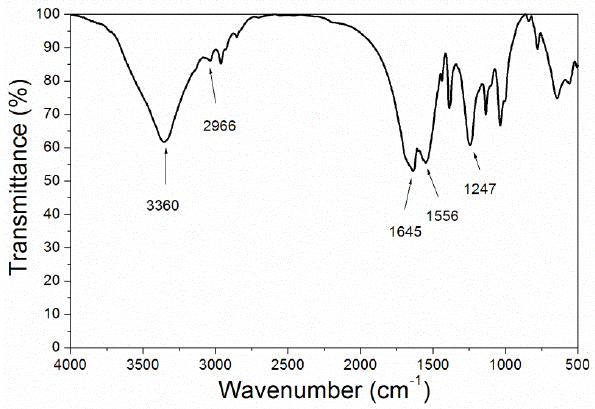
Figure 2. Particle size distribution of microcapsules.